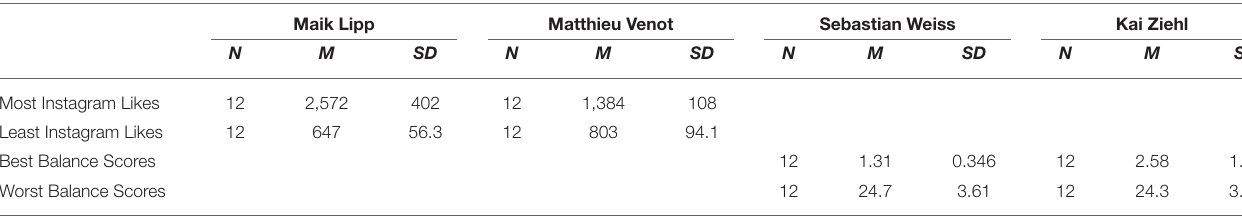
TABLE 2 | Descriptive statistics for the photographs used in study 1.